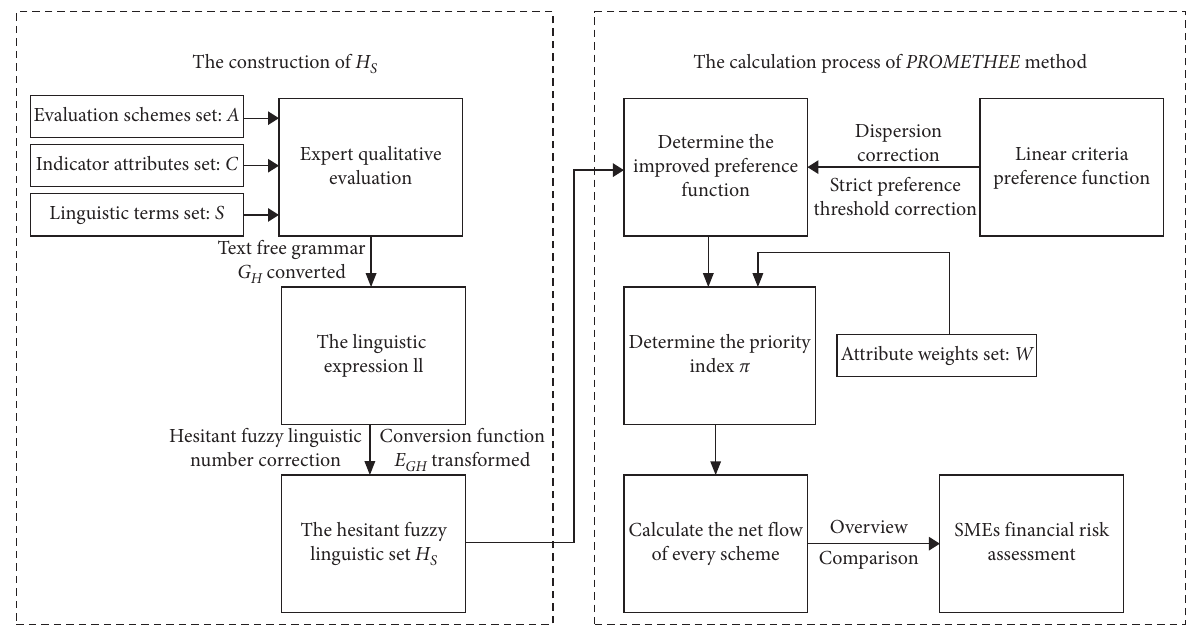
Figure 1: Research